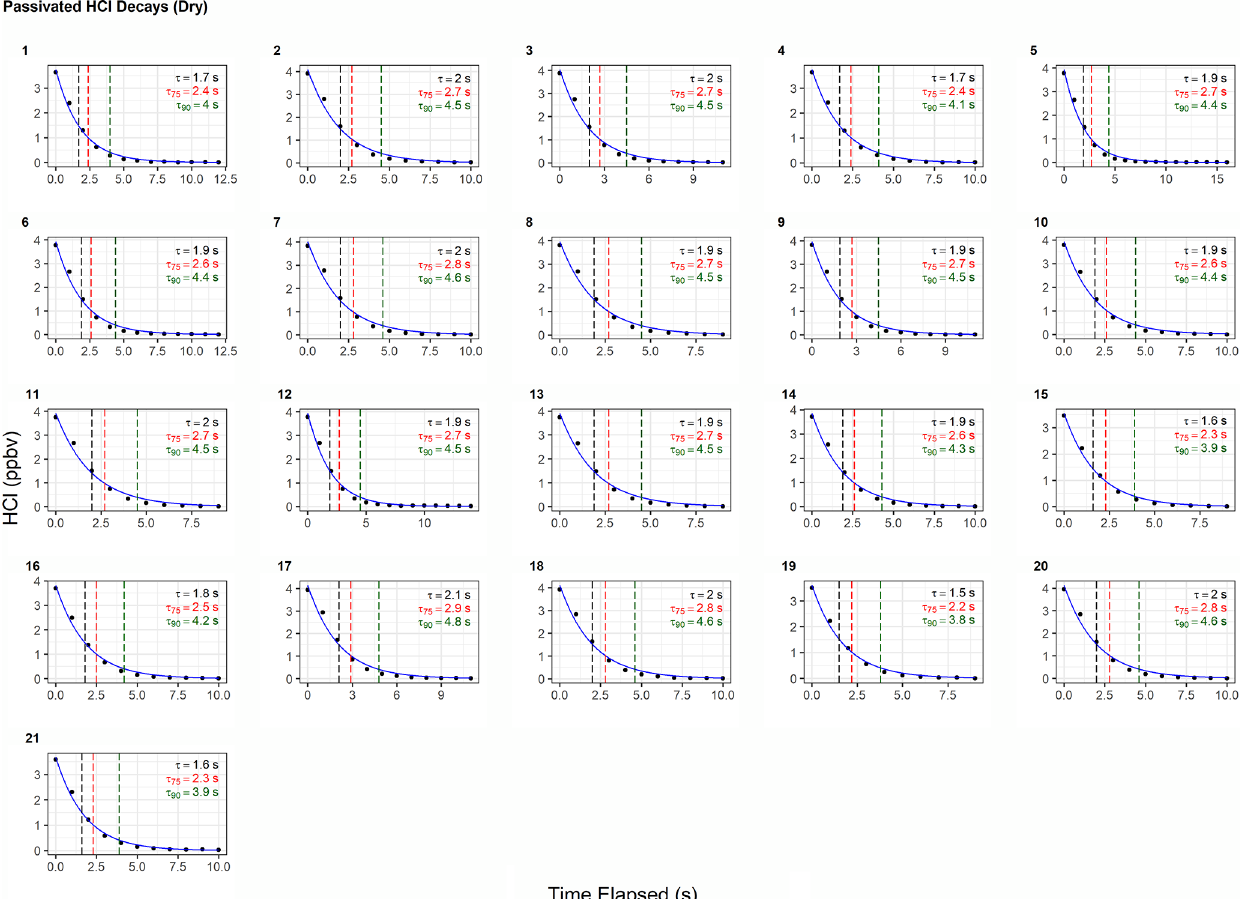
Figure A2. Instrument response times to changes in HCl mixing ratios utilizing active passivation. Black dots represent observed data and are overlaid by the calculated single-exponential model (according to the terms listed in Table A1). Vertical hashed lines are placed on time elapsed corresponding to τ e (black), τ 75 (red), and τ 90